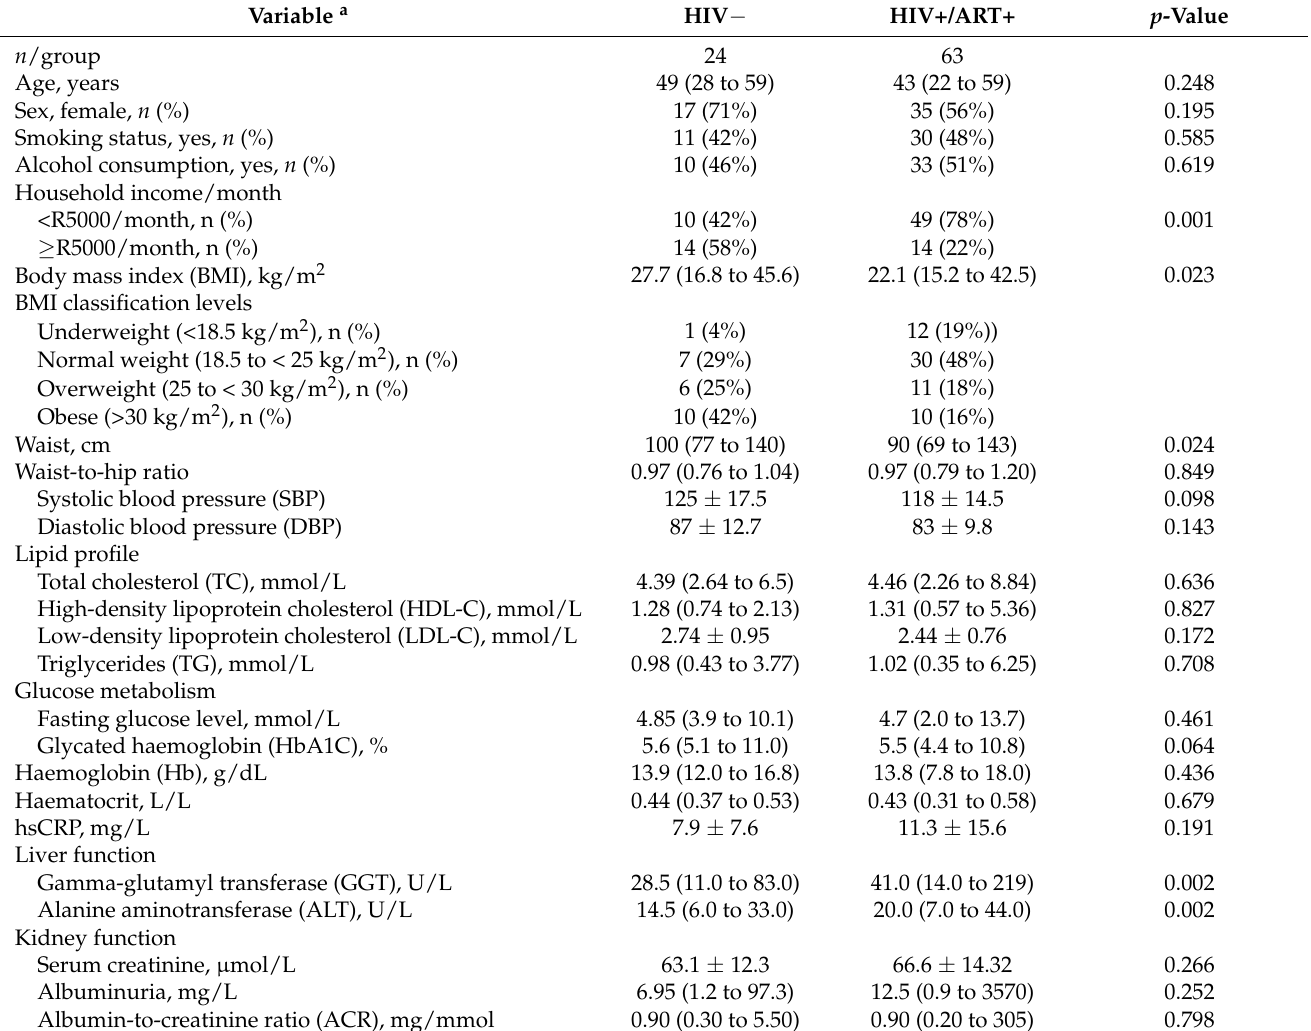
Table 1. Population